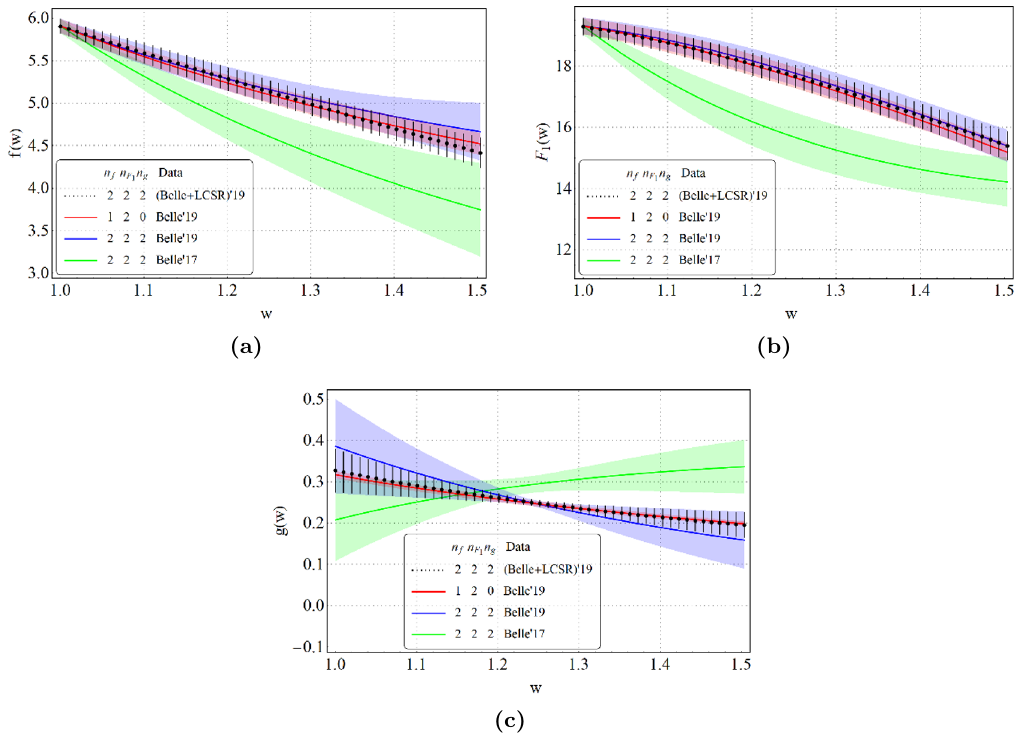
Figure 2. The shape of B ! D (cid:3) ‘(cid:23) ‘ form-factors obtained from the N = 2 (cid:12)t to new Belle data and LCSR inputs (black bars) is compared to those obtained with new Belle data for N = 2 (blue band) and for n f = 1 ; n F = 2 ; n g = 0 (red band), and also to the one obtained using old Belle data 1 (green band) for N =